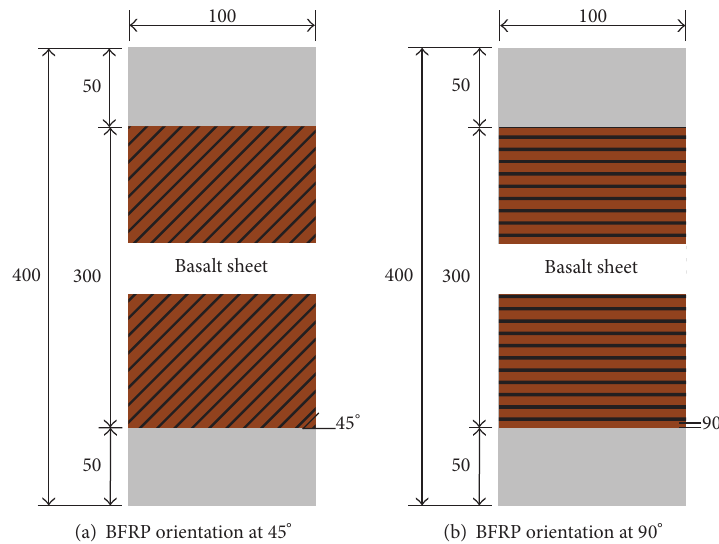
Figure 5: Top view of orientation of FRP sheets to the axis of beam (tension zone).